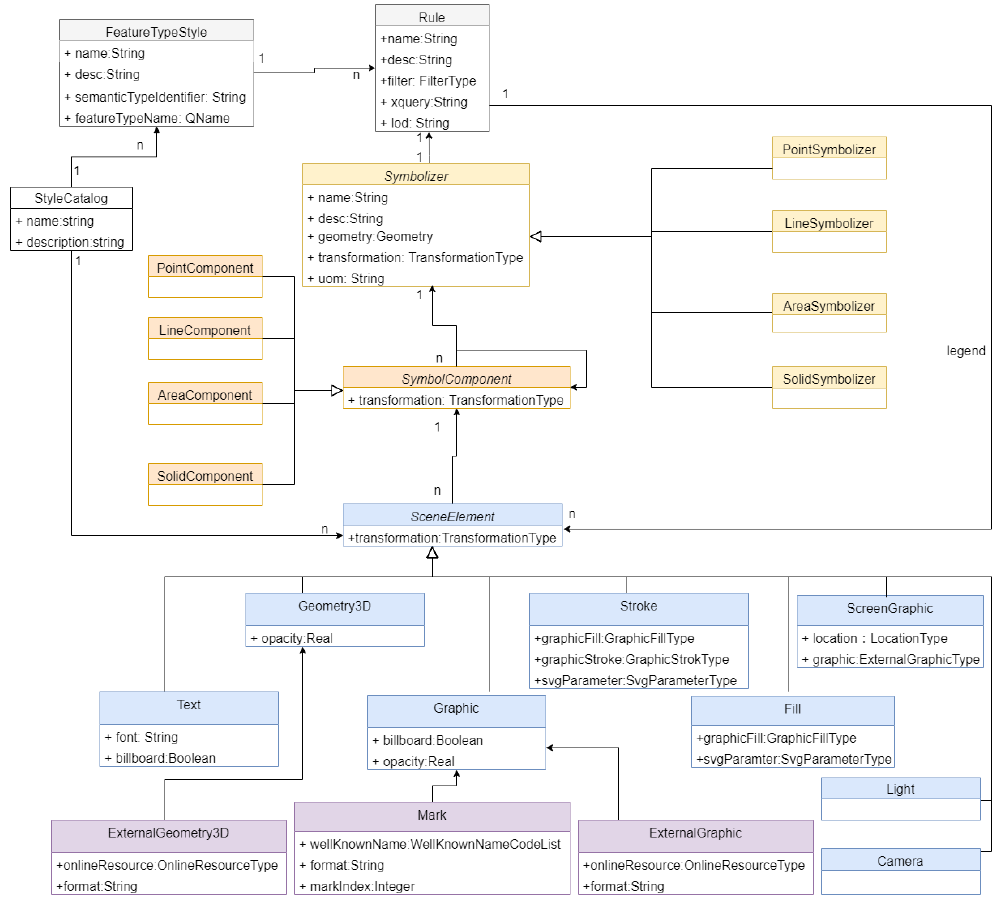
Figure 1. The UML diagram of the proposed 3D cadastre DCM SE module. The root of a 3D cadastre style is FeatureTypeStyle , which contains multiple Rules . Each Rule links with a symbolizer with multiple Symbolcomponents , and each Symbolcomponents links with some SceneElements.